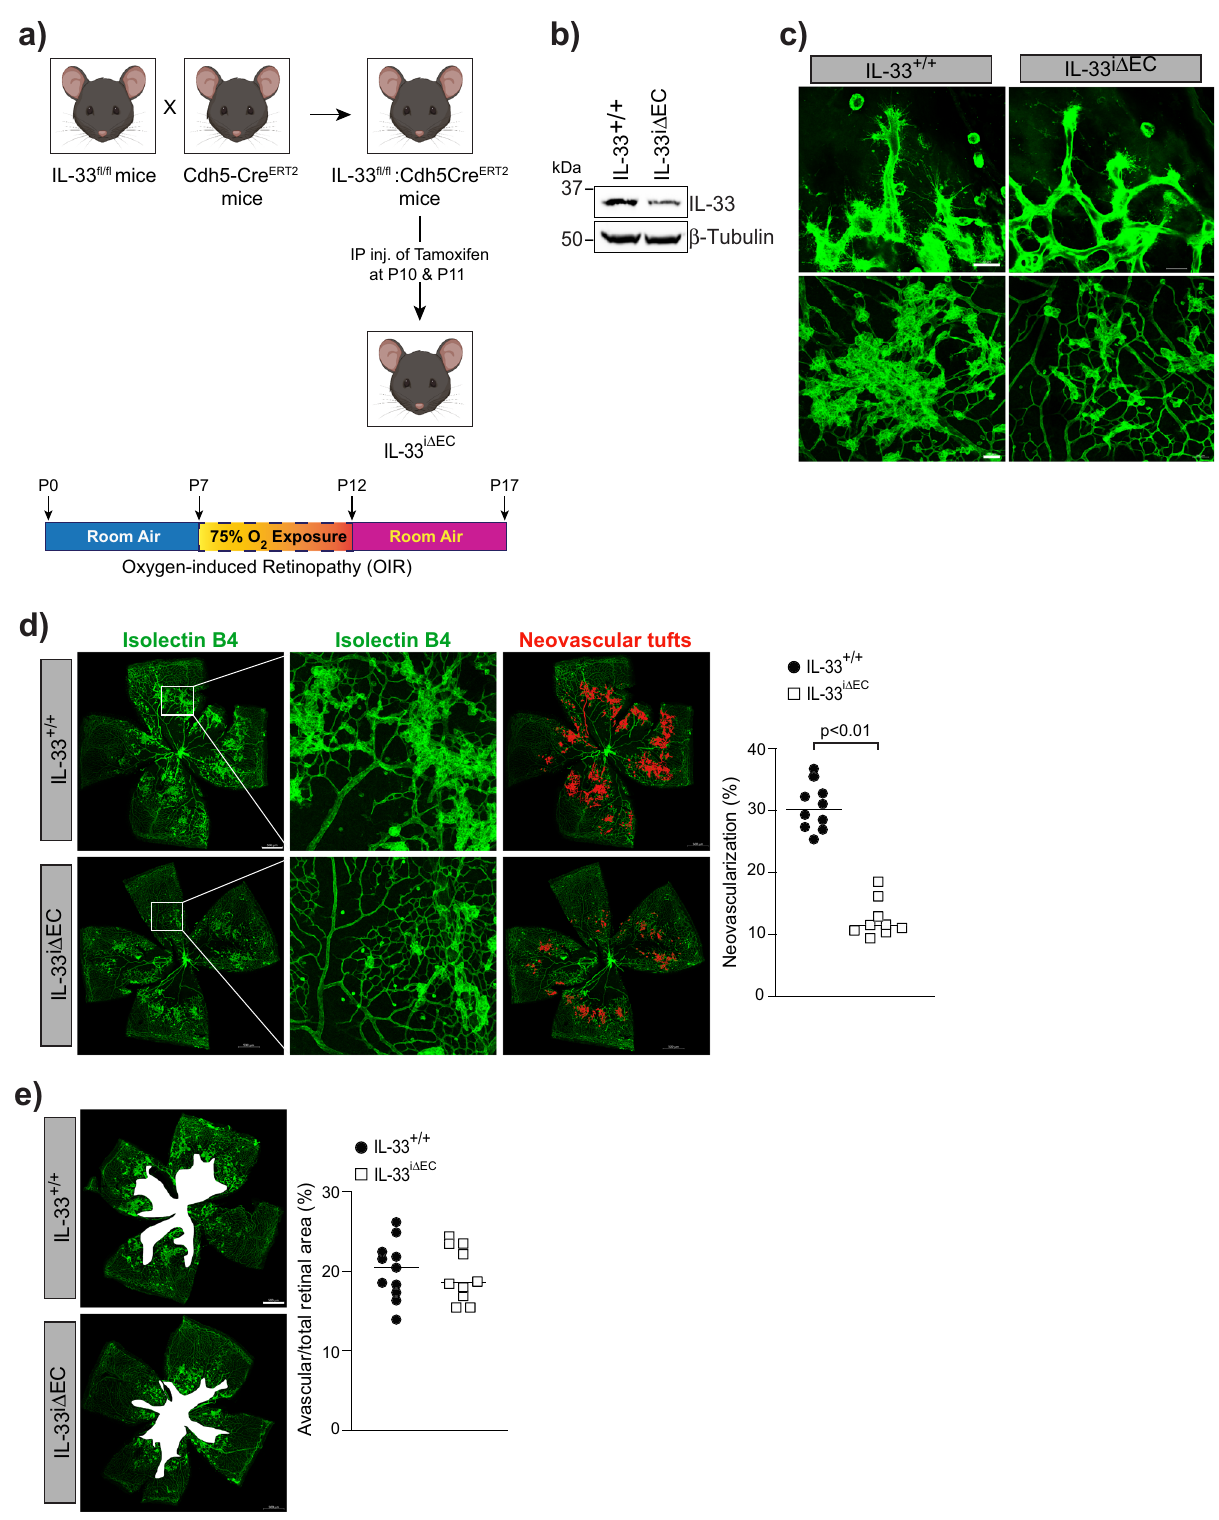
Fig. 5 Endothelial cells-speci fi c conditional deletion of IL-33 reduces hypoxia-induced pathological angiogenesis. a Schematic diagram to show the generation of endothelial cells-speci fi c IL-33 knockout mice. b Eyes from IL-33 + / + and IL-33 i Δ EC pups were enucleated, retinas isolated, and extracts were analyzed for IL-33 levels by Western blotting and normalized to β -tubulin. c – e IL-33 + / + and IL-33 i Δ EC mice pups were exposed to OIR and at P17 the retinas were isolated, stained with isolectin B4, and fl at mounts were examined for endothelial tip cell formation ( c ) retinal neovascularization ( d ), and avascular area ( e ). The middle column in d shows the higher magni fi cation of the area selected. Neovascularization is highlighted in red in the third column of d . The bar graphs represent quantitative analysis of percentage of neovascularization and avascular area, expressed as Mean± SD. * P < 0.05 vs IL-33 + / + . Scale bar represents 20 μ m in c upper row, 50 μ m in c lower row, 500 μ m in d , e